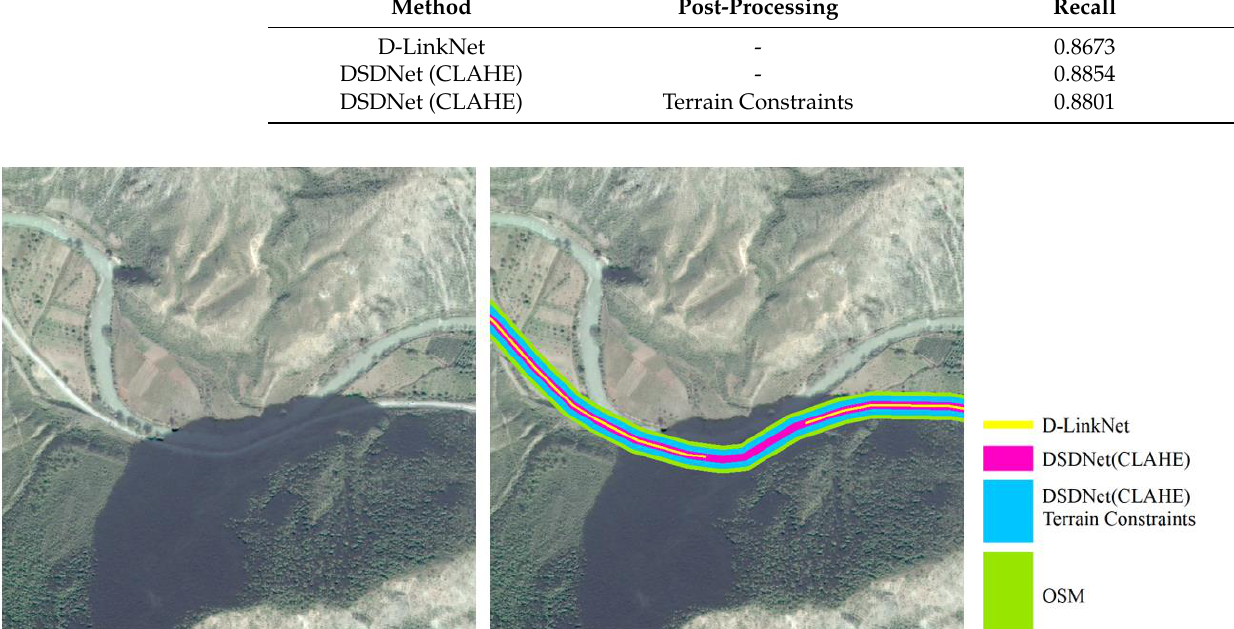
Figure 12. Comparison of results for each method used in a typical road area.